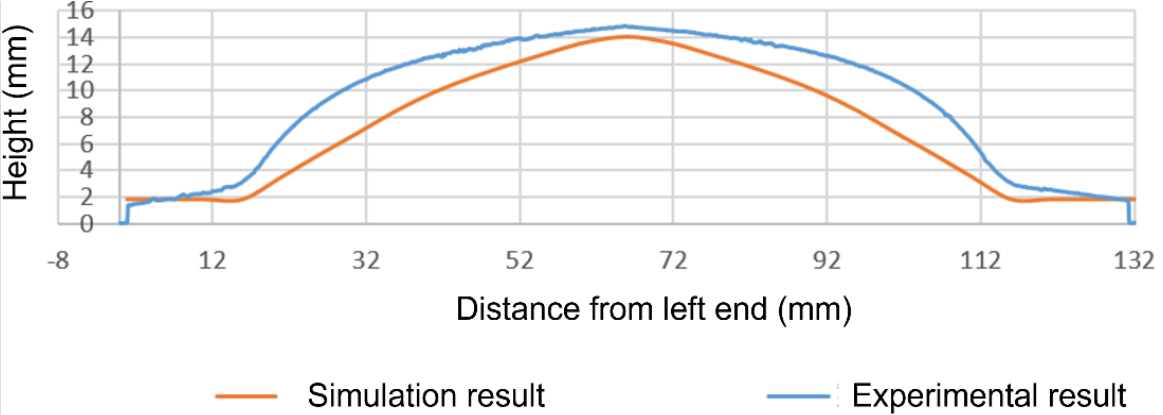
Figure 14. Comparison of numerical simulation and forming experiment results for the AZ31 forming shape.